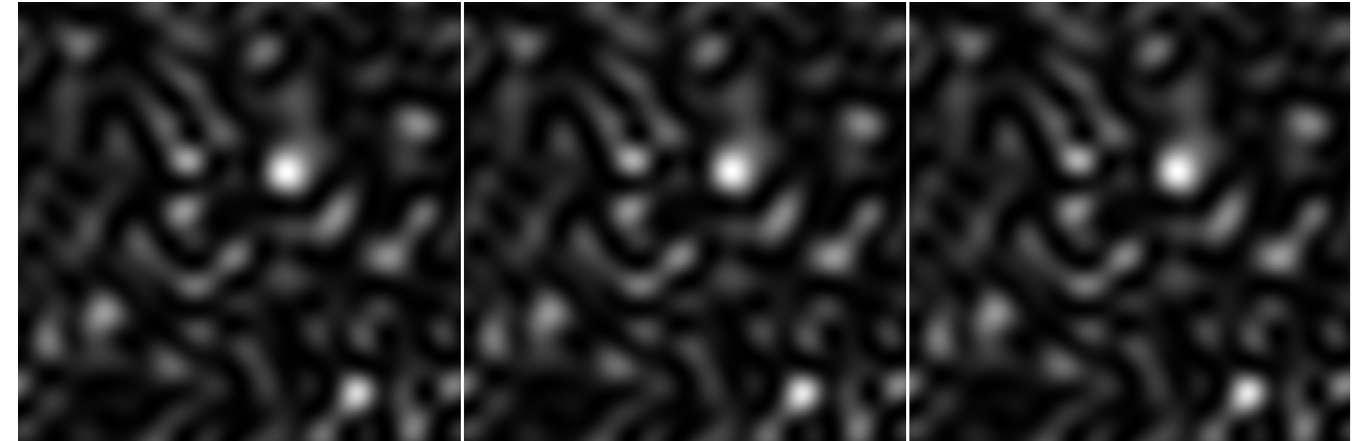
Fig 1. GB-speckles, obtained for oppA gene. (a) strain E/Bour, ST94. (b) strain G/9301, ST 95. (c) strain G/11222, ST94.